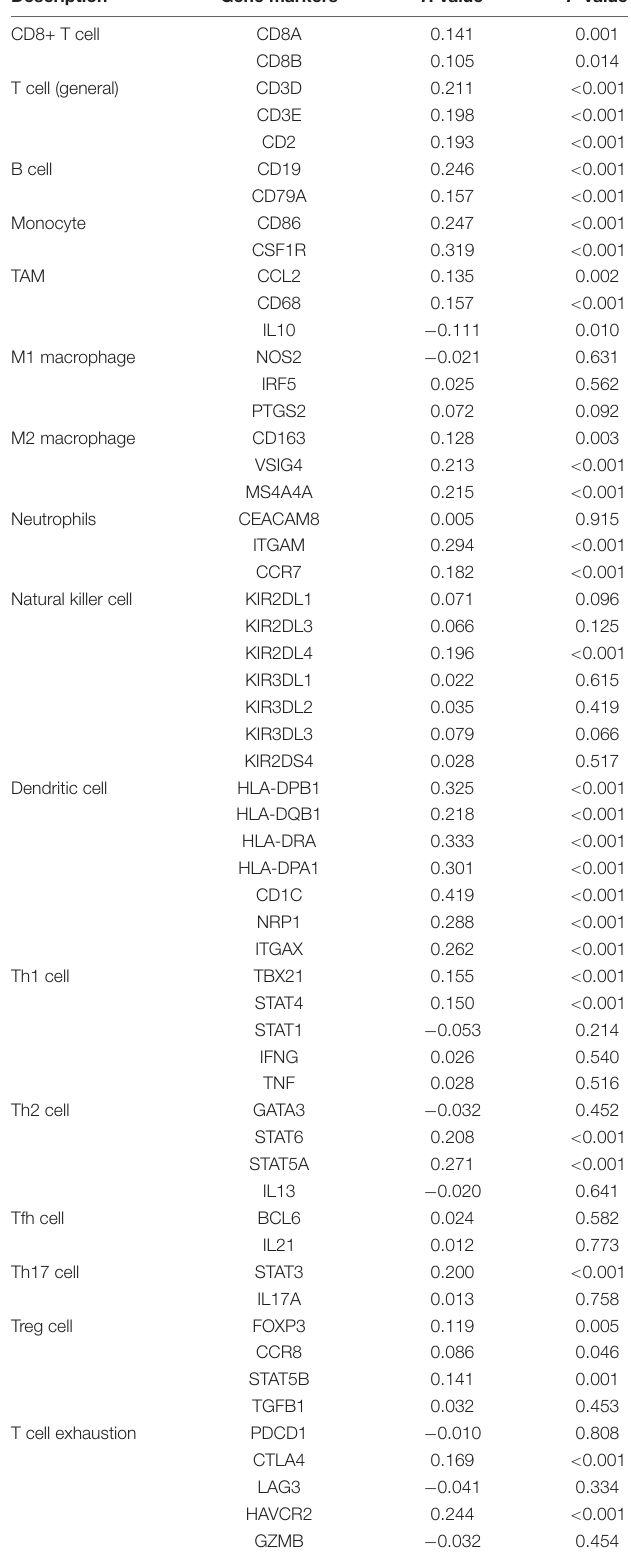
TABLE 2 | Correlation analysis between RILPL2 and related gene markers of immune